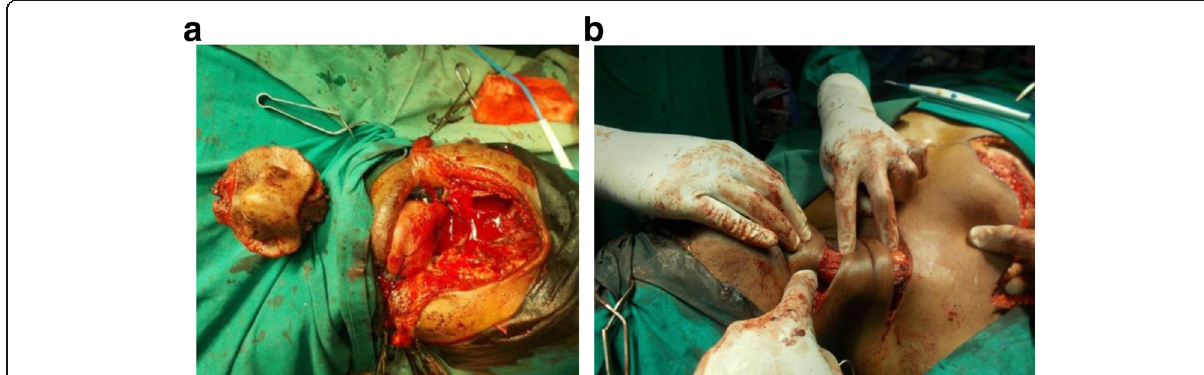
Fig. 1 a The procedure of rhinectomy and right antrostomy. The anterior maxillectomy with disease-free margins covering the nasal area, right maxillary sinus, and the pyriform aperture till the ethmoid bilaterally. b The procedure of a flap tunneling up to the defect as planned through the neck and masseter. The mobilization of pectoralis major myocutaneous flap tunneling behind the sternocleidomastoid muscle and platysma